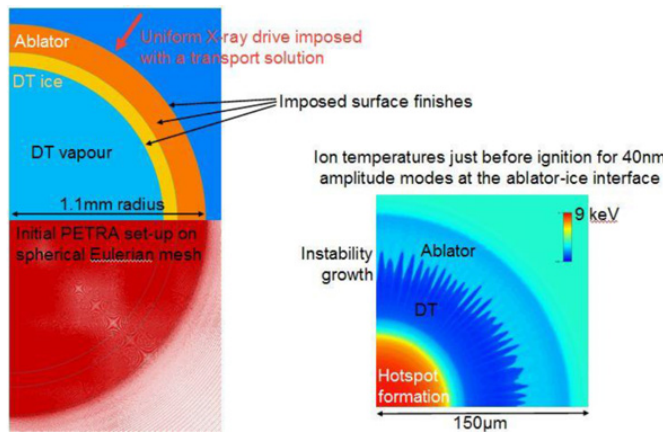
Figure 4. Calculation of perturbation